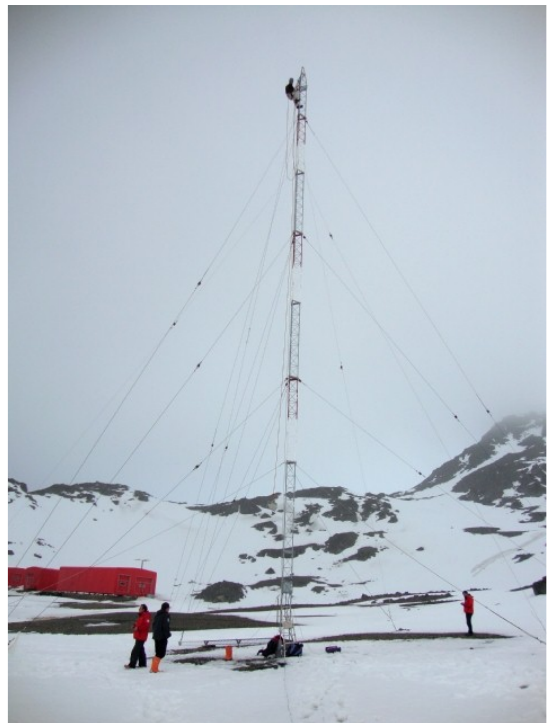
Figure 5. The vertical incidence ionospheric sounder (VIS) installed at the ASJI is the Advanced Ionospheric Sounder (AIS) developed by the Instituto Nazionale di Geofisica e Vulcanologia (INGV) of Rome, Italy. For more details about the ionosonde, see [12].